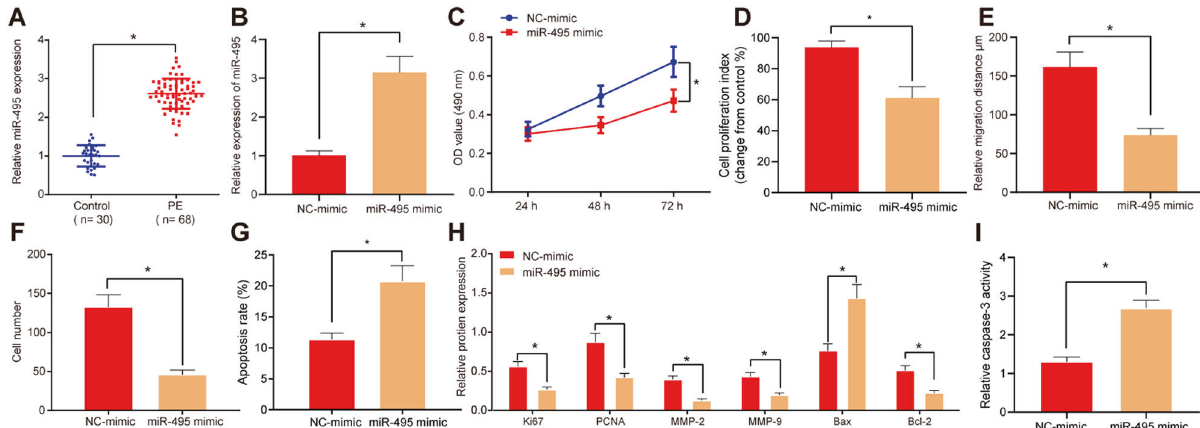
Fig. 1 miR-495 expression is increased in PE. A Expression of miR-495 in umbilical cord tissues analyzed by RT-qPCR (control n = 30, PE n = 68). B Expression of miR-495 in HTR8/SVneo cells 48 h after transfection via RT-qPCR. C HTR8/SVneo cell viability at 24 th , 48 th , and 72 nd hour after transfection evaluated by MTT assay. D HTR8/SVneo cell proliferation 48 h after transfection evaluated by BrdU assay. E Migrating ability of HTR8/SVneo cells 24 h after transfection examined using scratch assay. F HTR8/SVneo cell invasion 24 h after transfection assessed using transwell assay (200×). G HTR8/SVneo cell apoptosis in each group 48 h after transfection analyzed by fl ow cytometry. H Protein expression of proliferation-related factors (Ki67 and PCNA), migration- and invasion-related factors (MMP-2 and MMP-9), and apoptotic factors (Bax and Bcl-2) in HTR8/SVneo cells 48 h after transfection studied by western blot. I Caspase-3 activity in HTR8/SVneo cells 48 h after transfection. * p < 0.05 vs. control or NC mimic. The quantitative data were presented as mean ± standard deviation. Difference between two groups was compared using paired t- test. Cell experiments were repeated 3